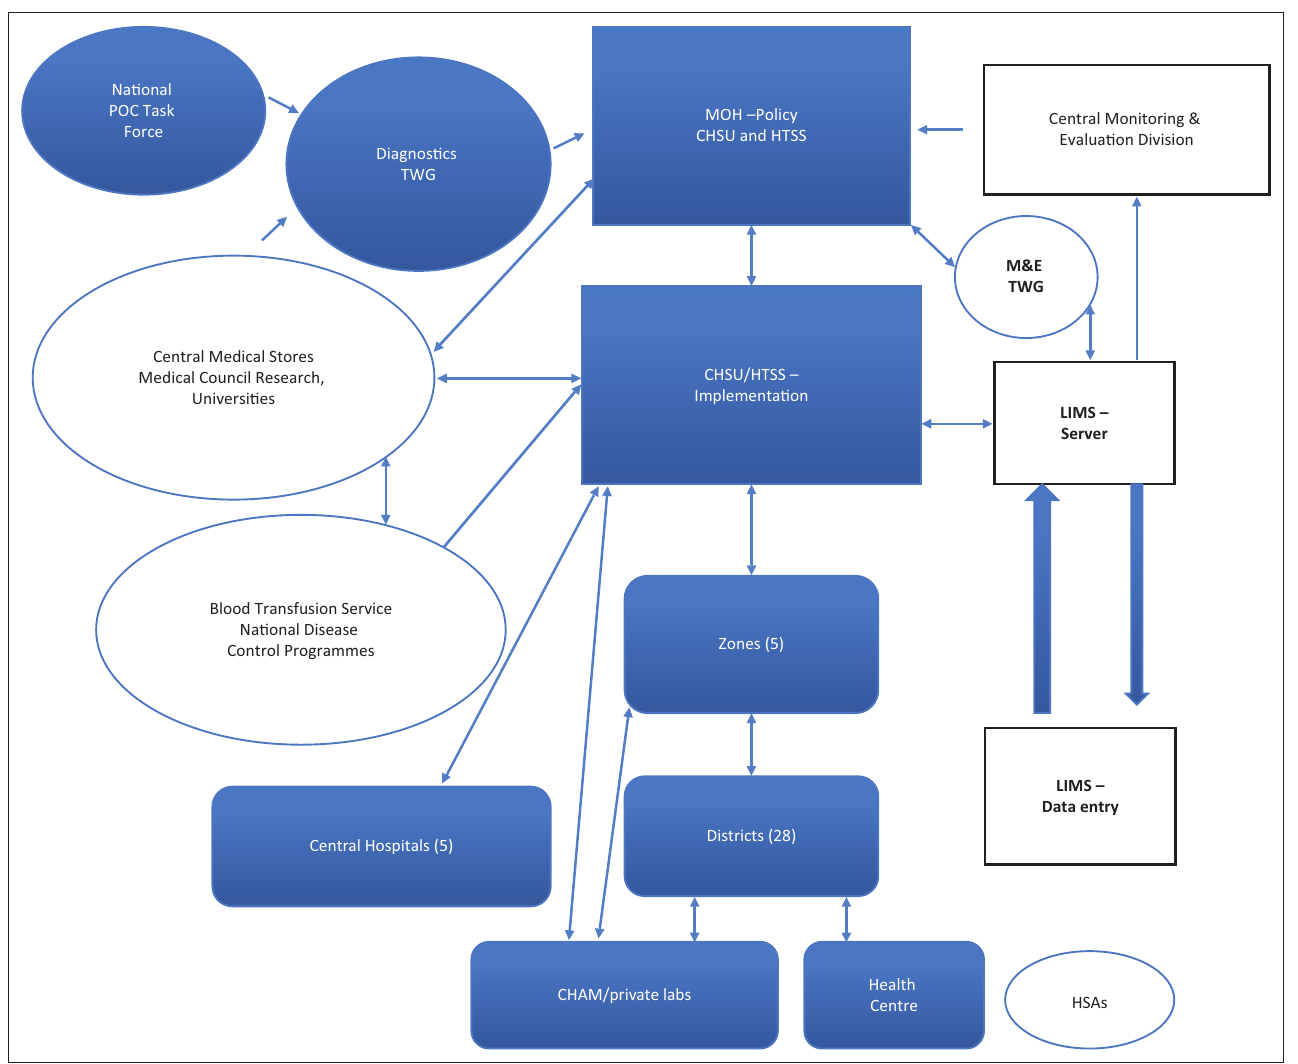
FIGURE 2: Malawi’s centralised quality assurance